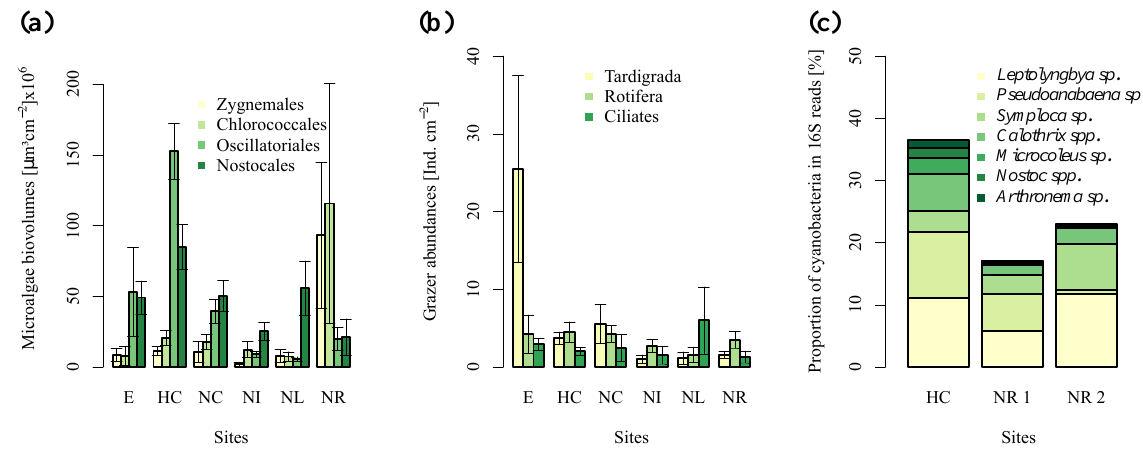
Figure 2. Mean densities in cryoconite sediment layers of microalgae (a) in (µm 3 cm − 2 ) × 10 − 6 and grazers (b) in individuals per square centimeter for the different sites (E: Ebbabreen; HC: Hørbyebreen; NC: Nordenskiöldbreen; NI: Nordenskiöldbreen plateau; NL: supraglacial pond on Nordenskiöldbreen; NR: Retrettøya). The error bars indicate the standard errors. Panel (c) shows the proportion of different cyanobacterial genera within all 16S sequences from 2012 on Hørbyebreen (HC) and Nordenskiöldbreen (no. 1, no. 2).